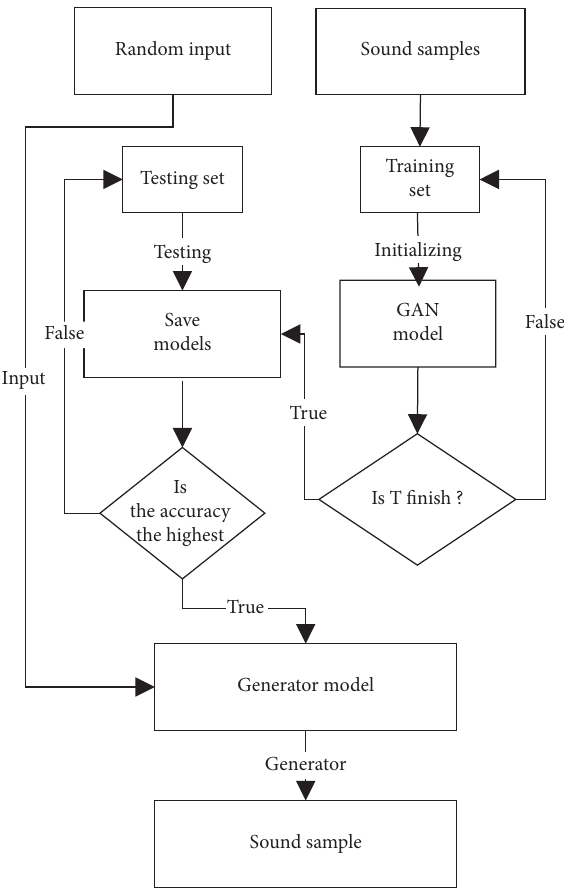
Figure 2: Active sound production